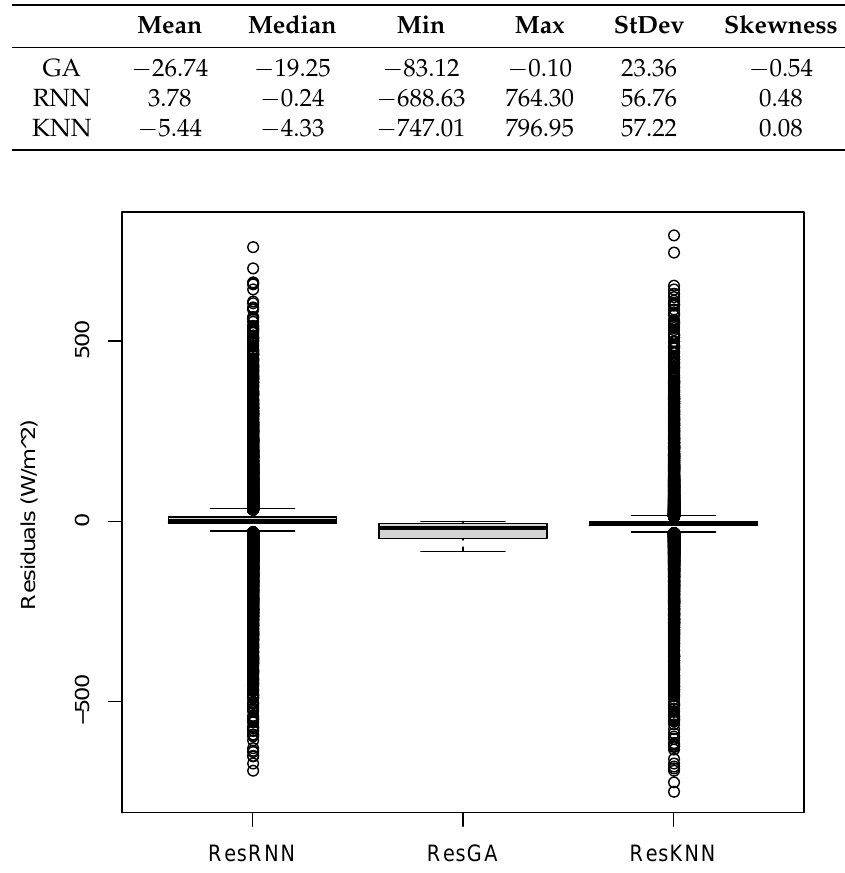
Table 7. Residual comparison of the models.